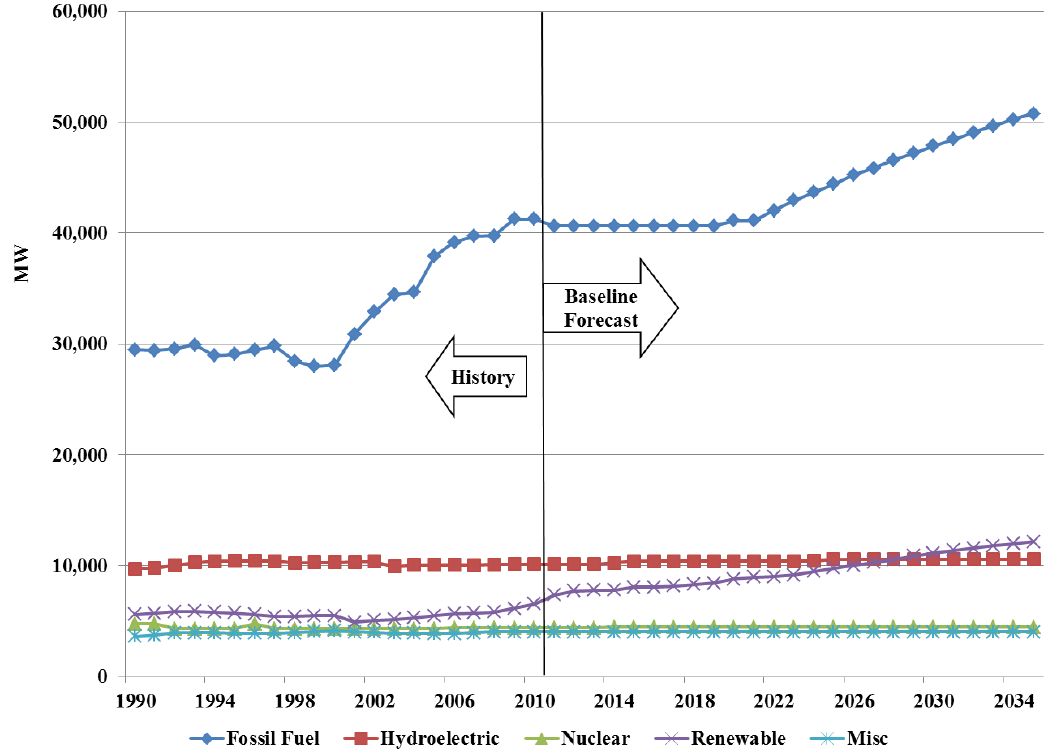
Figure 2. Projected baseline electricity generation